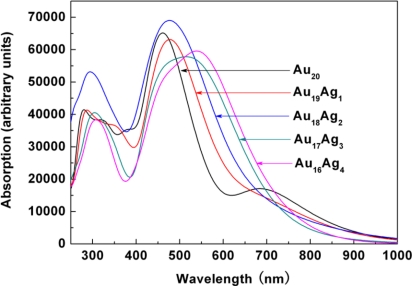
Optical absorption of Au20−nAgn clusters.